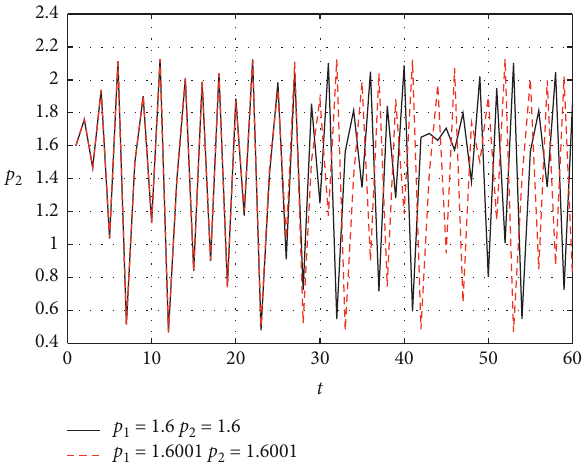
Figure 7: Price changing diagram ( p